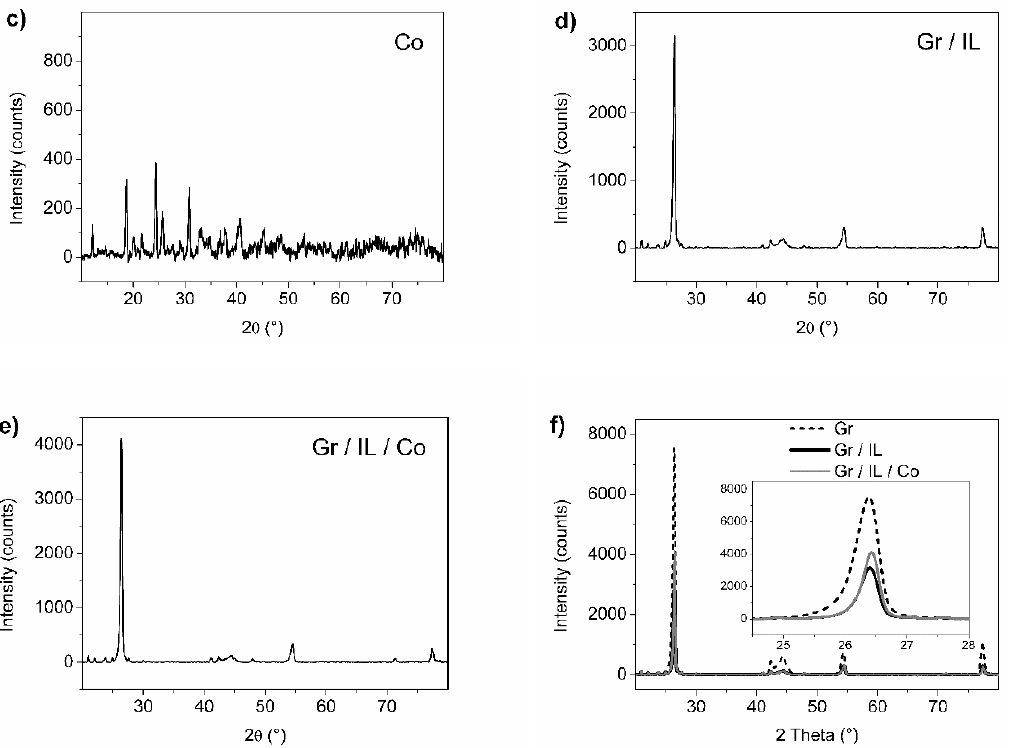
Figure 1. Diffractograms for the graphite paste/ionic liquid (Gr/IL) and Gr/IL/Co systems and their components. ( a ) Graphite powder, ( b ) IL OPyPF 6 ( c ) cobalt (II) 2,3,7,8,12,13,17,18-octaethyl-21H,23H-porphine, ( d ) system Gr/IL ( e ) system Gr/IL/Co and ( f ) systems comparison.